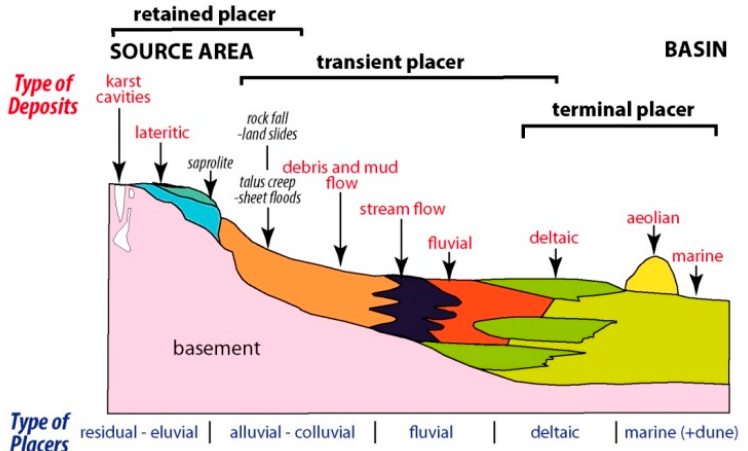
Figure 49. The different types of placer deposits formed on the continental surface and deltaic or marine basins, modified from [138]. The majority of these types of placer, except for aeolian and marine placers, occur for gem corundum deposits